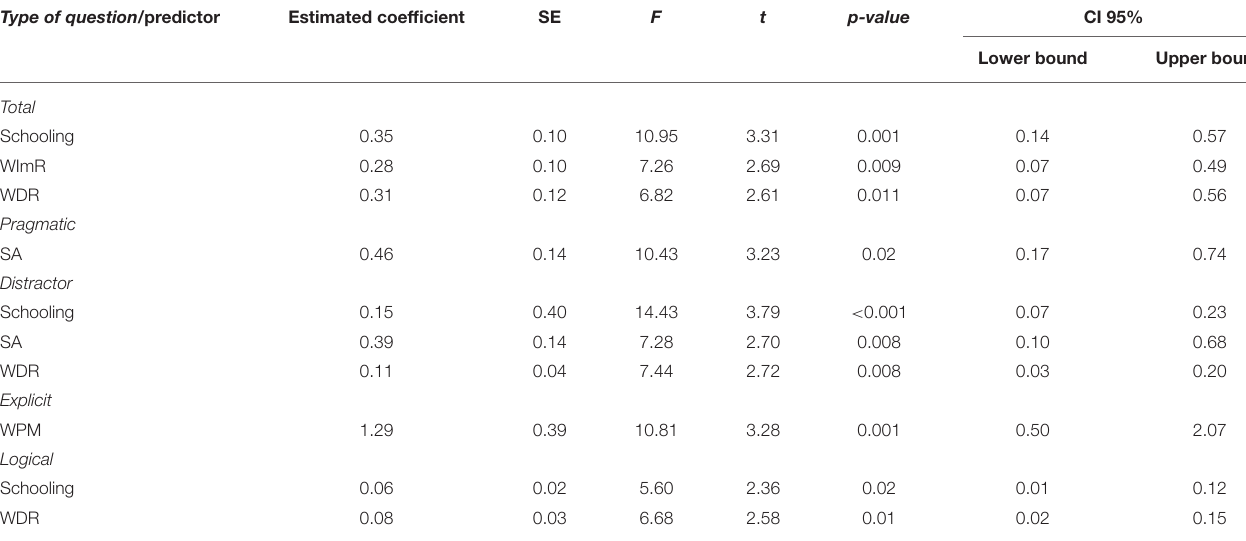
TABLE 3 | Mixed-effect linear regression for predictors of IMT scores according to the type of question in the whole sample. Type of question /predictor